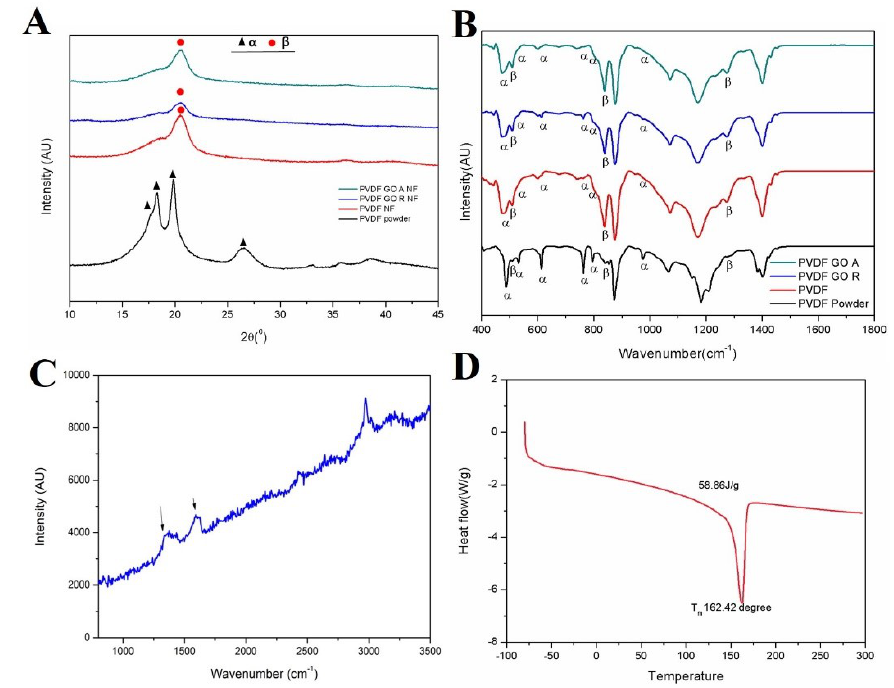
Figure 2. ( A ) XRD, ( B ) FTIR showing the β phase nucleation in the NF samples, ( C ) Raman spectra Figure 2. A ) XRD, B ) FTIR showing the β phase nucleation in the NF samples, C ) Raman spectra showing the characteristic peak of GO in the PGANF, ( D ) DSC thermograph of PGANF showing the showing the characteristic peak of GO in the PGANF, D ) DSC thermograph of PGANF showing the melting temperature melting temperature Tm.